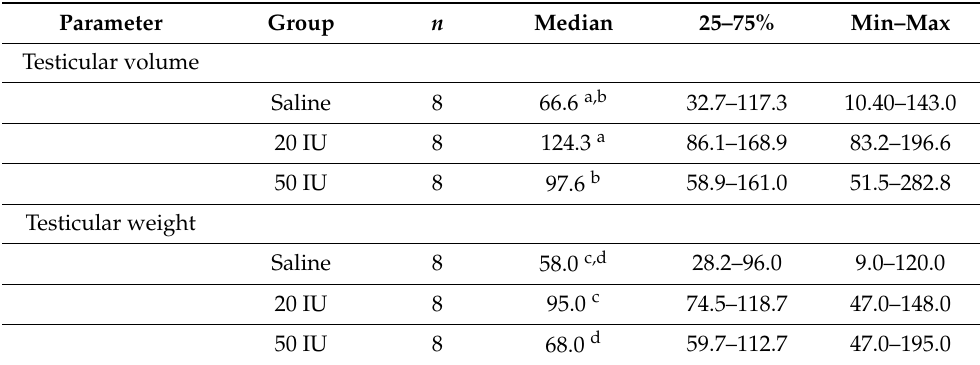
Table 3. Leopard gecko post-surgical testicular volume (mm 3 ) and weight (grams) by treat- ment